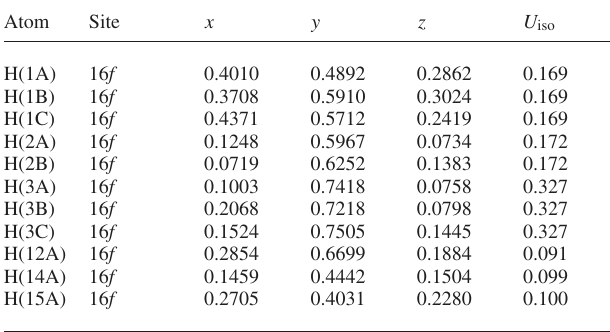
Table 2. Atomic coordinates and displacement parameters (in Å 2 )